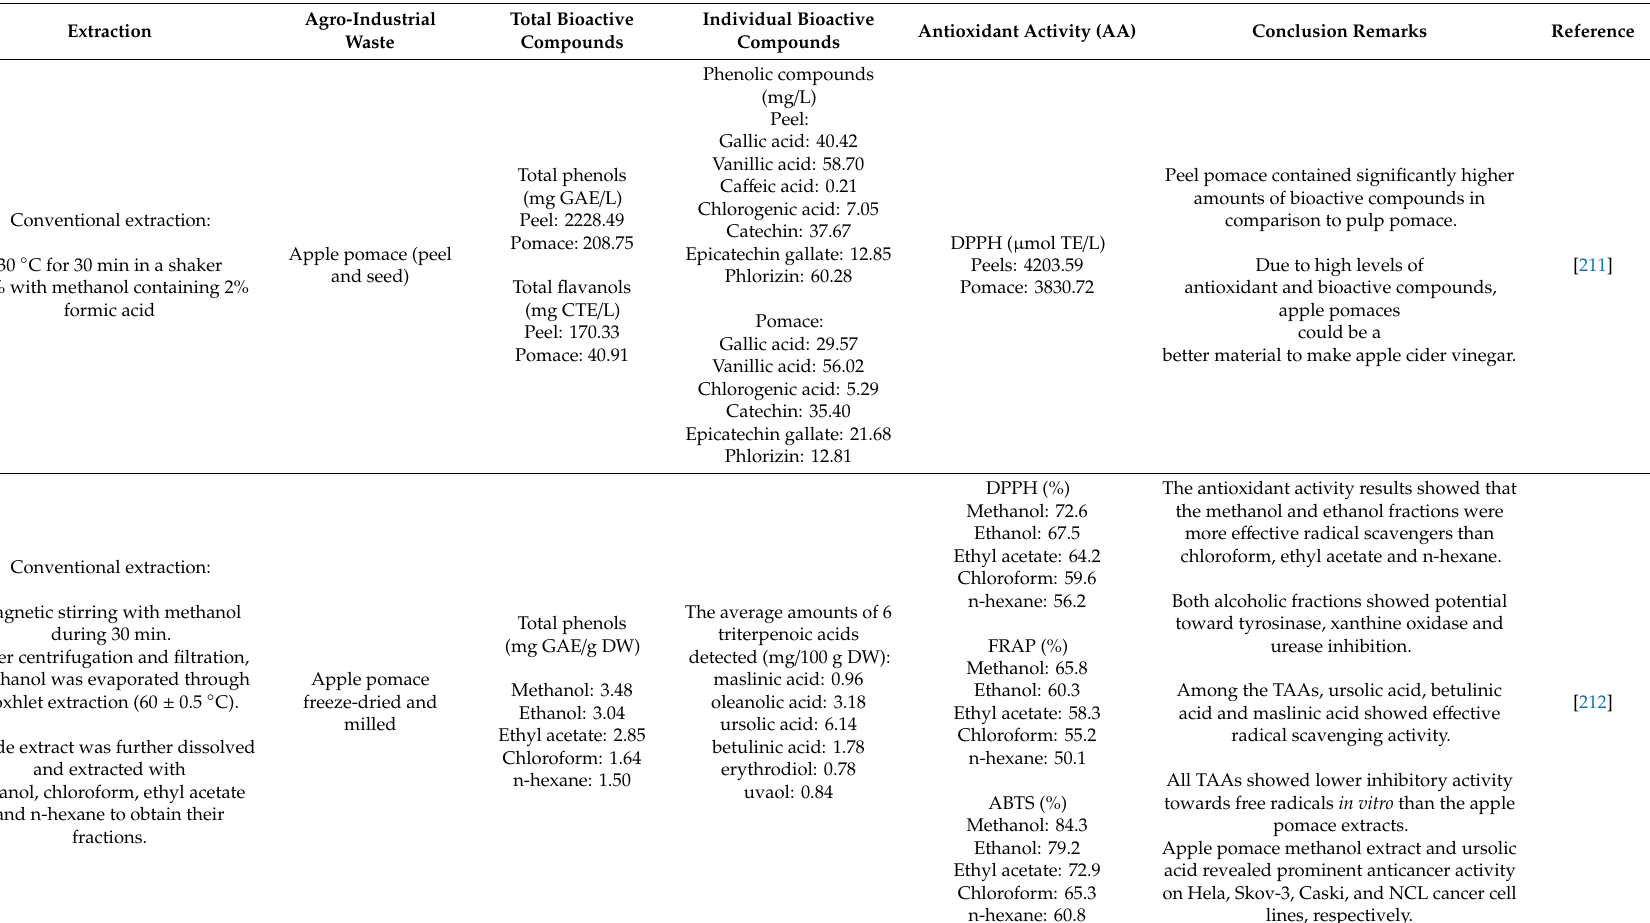
Table 3. Examples of extractions of bioactive compound from apple